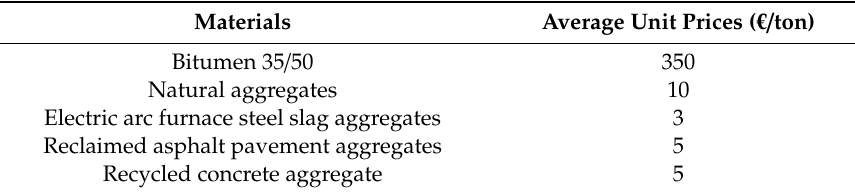
Table 1. Cost evaluation of typical asphalt